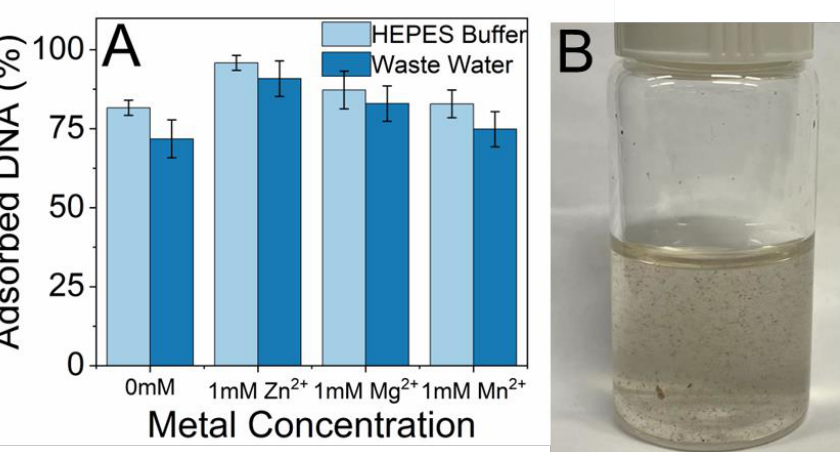
Figure 5. ( A ) Adsorption of 1 µ M salmon sperm dsDNA (~2000 bp) onto 500 µ g/mL of PET microplastics in the absence/presence of 1 mM of various metal ions in wastewater or a buffer (10 mM HEPES, pH 7.6). ( B ) A photograph of the wastewater sample used in this